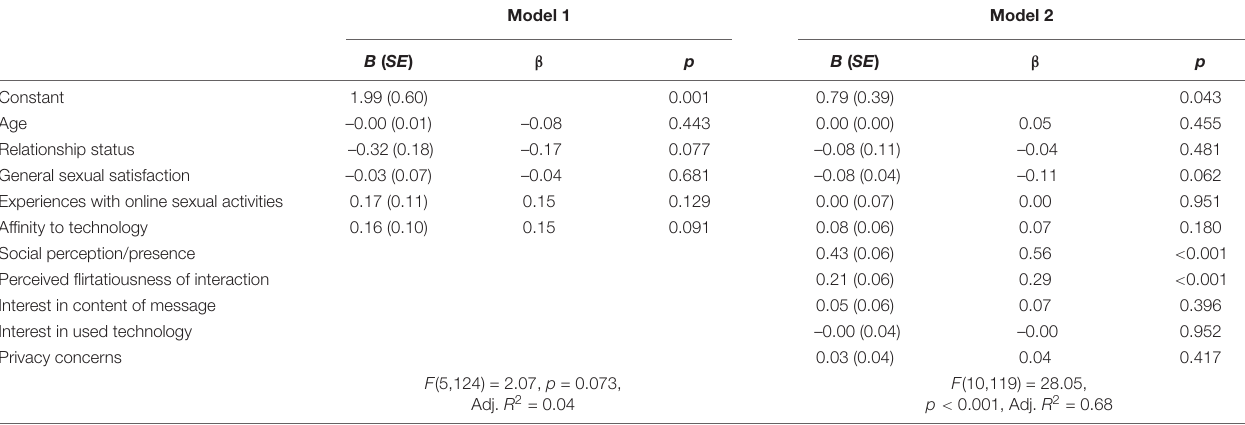
TABLE 4 | Hierarchical regression analysis of the voice assistants perceived sexual